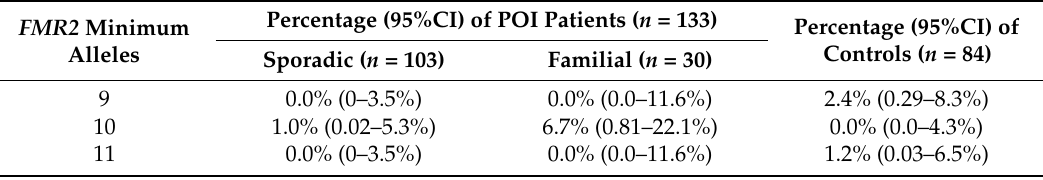
Table 2. Percentage of minimum FMR2 alleles in POI patients and controls, after PCR. FMR2 Minimum